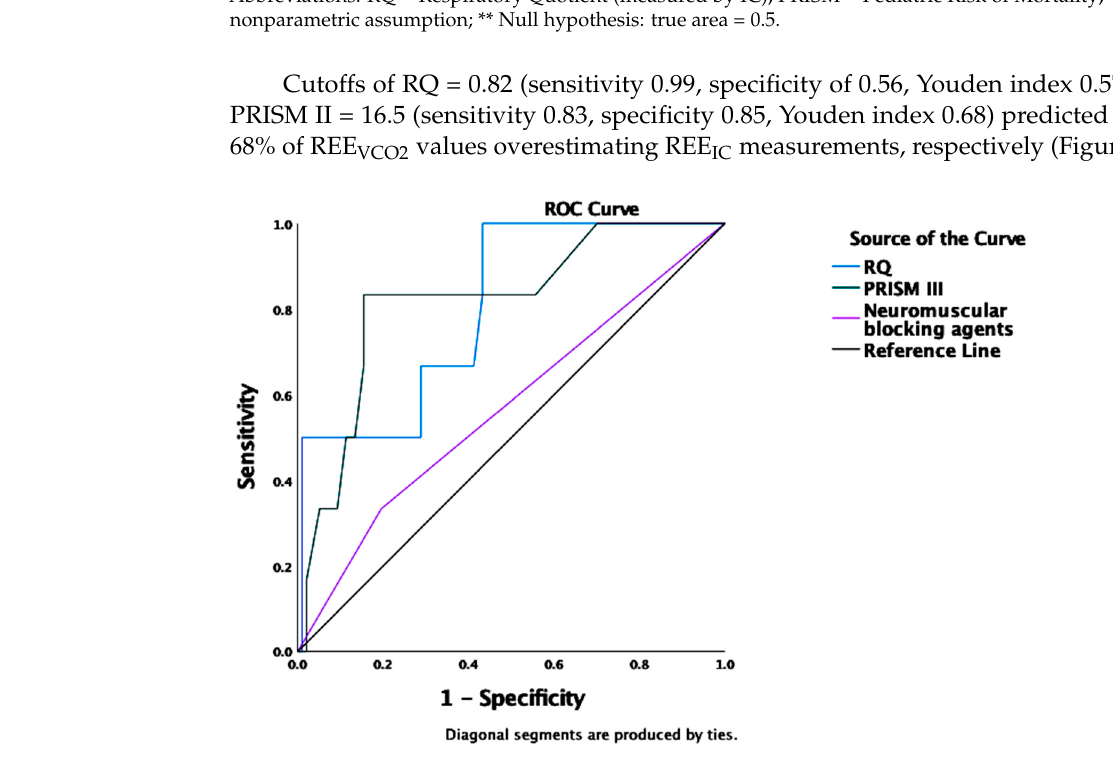
Figure 5. An Area Under the Receiver Operating Characteristic Curve (AUROC) for predicting REE VCO2 RQ 0.89 overestimating REE IC for more than +10%. Only the measured RQ (AUROC 0.804 (95%CI 0.643–0.966), p = 0.013) and a high PRISM III score (AUROC 0.819 (95%CI 0.646–0.992), p = 0.009) were strong predictors of REE VCO2